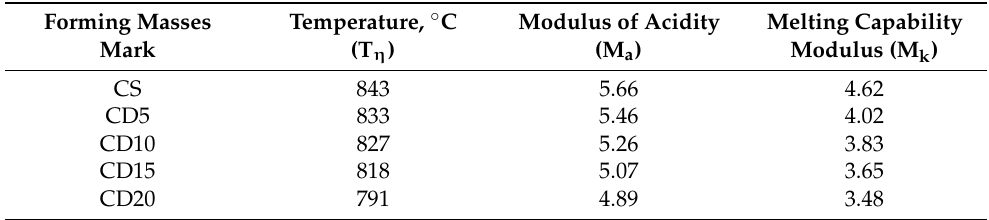
Table 4. The calculated temperature at the target viscosity, modulus of acidity, and melting capability